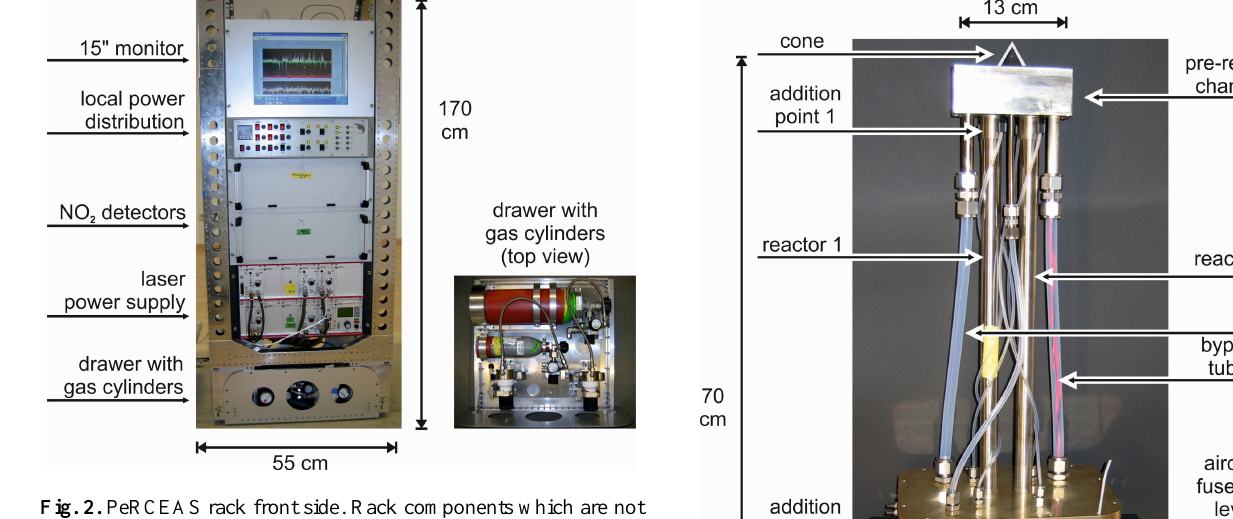
14.2 mm height) protruding into the pre-reactor